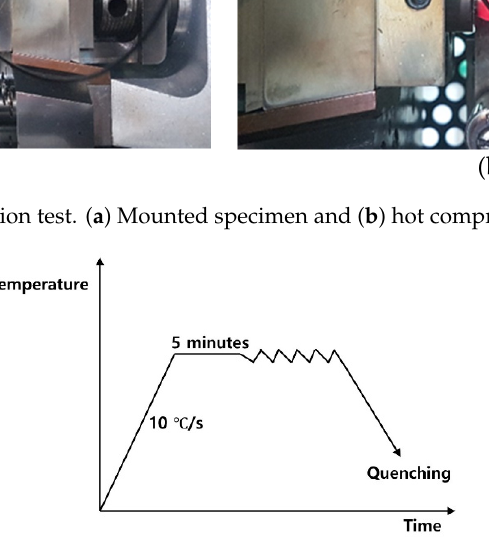
Figure 2. Schedule of isothermal hot compression test.